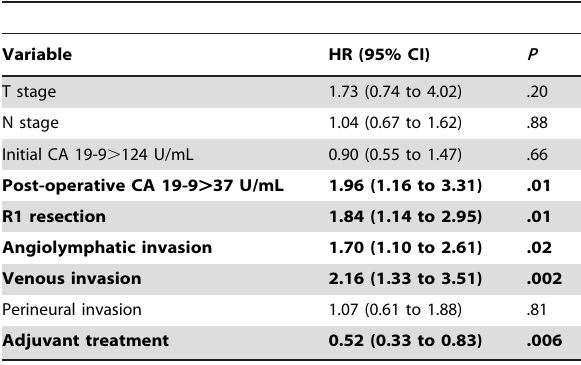
Table 2. Prognostic factors affecting overall survival in R0 and R1 resection by multivariate analysis.